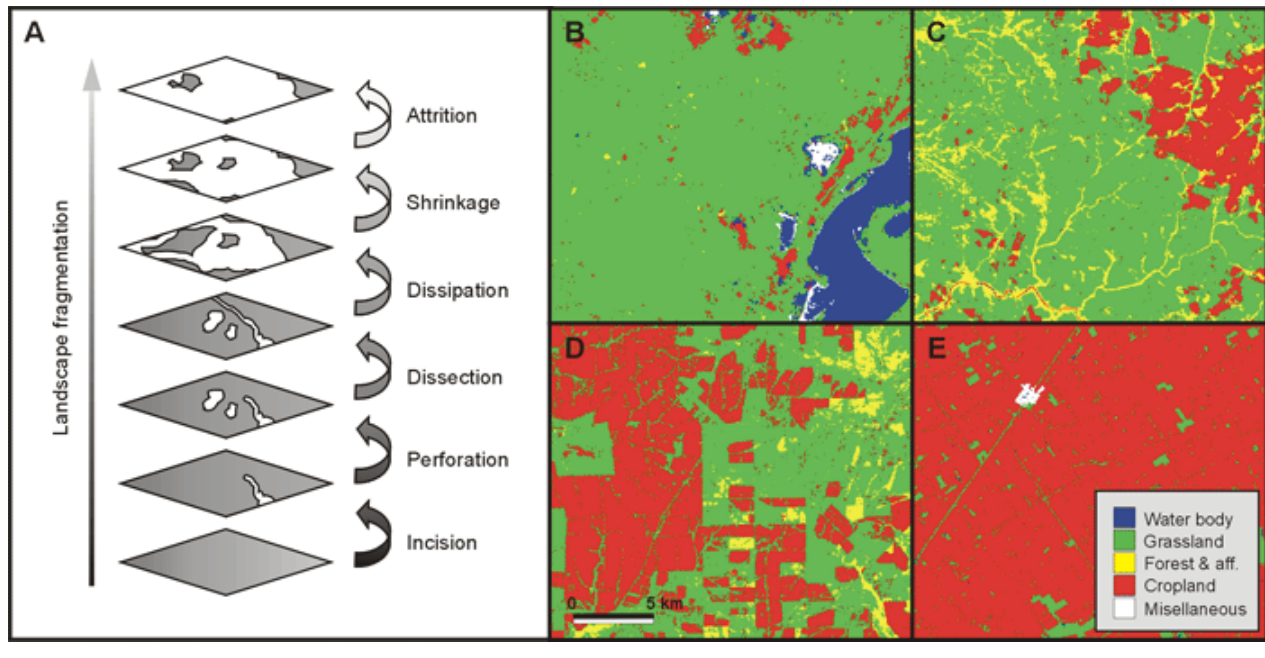
Fig. 6. (A) Schematic representation of the fragmentation process at different stages, modified from Forman (1995) and Jaeger (2000). Gray represents the original land cover; white represents anthropogenic or new land cover. Landscape cover type in 2002–2004 in: (B) Flooding Pampa, (C) Northern Campos, (D) Mesopotamic Pampa, and (E) Rolling